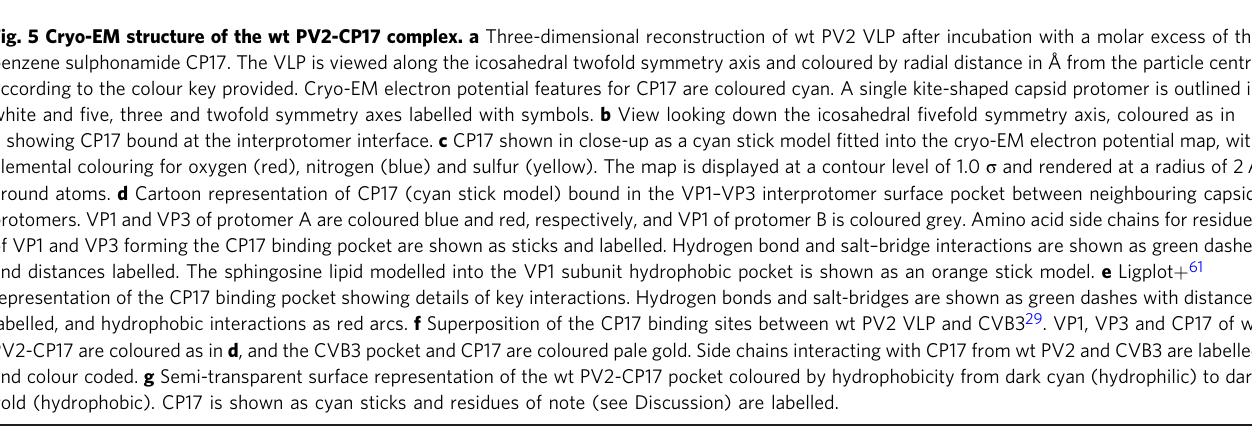
Fig. 5 Cryo-EM structure of the wt PV2-CP17 complex. a Three-dimensional reconstruction of wt PV2 VLP after incubation with a molar excess of the benzene sulphonamide CP17. The VLP is viewed along the icosahedral twofold symmetry axis and coloured by radial distance in Å from the particle centre according to the colour key provided. Cryo-EM electron potential features for CP17 are coloured cyan. A single kite-shaped capsid protomer is outlined in white and fi ve, three and twofold symmetry axes labelled with symbols. b View looking down the icosahedral fi vefold symmetry axis, coloured as in a showing CP17 bound at the interprotomer interface. c CP17 shown in close-up as a cyan stick model fi tted into the cryo-EM electron potential map, with elemental colouring for oxygen (red), nitrogen (blue) and sulfur (yellow). The map is displayed at a contour level of 1.0 σ and rendered at a radius of 2 Å around atoms. d Cartoon representation of CP17 (cyan stick model) bound in the VP1 – VP3 interprotomer surface pocket between neighbouring capsid protomers. VP1 and VP3 of protomer A are coloured blue and red, respectively, and VP1 of protomer B is coloured grey. Amino acid side chains for residues of VP1 and VP3 forming the CP17 binding pocket are shown as sticks and labelled. Hydrogen bond and salt – bridge interactions are shown as green dashes and distances labelled. The sphingosine lipid modelled into the VP1 subunit hydrophobic pocket is shown as an orange stick model. e Ligplot + 61 representation of the CP17 binding pocket showing details of key interactions. Hydrogen bonds and salt-bridges are shown as green dashes with distances labelled, and hydrophobic interactions as red arcs. f Superposition of the CP17 binding sites between wt PV2 VLP and CVB3 29 . VP1, VP3 and CP17 of wt PV2-CP17 are coloured as in d , and the CVB3 pocket and CP17 are coloured pale gold. Side chains interacting with CP17 from wt PV2 and CVB3 are labelled and colour coded. g Semi-transparent surface representation of the wt PV2-CP17 pocket coloured by hydrophobicity from dark cyan (hydrophilic) to dark gold (hydrophobic). CP17 is shown as cyan sticks and residues of note (see Discussion)